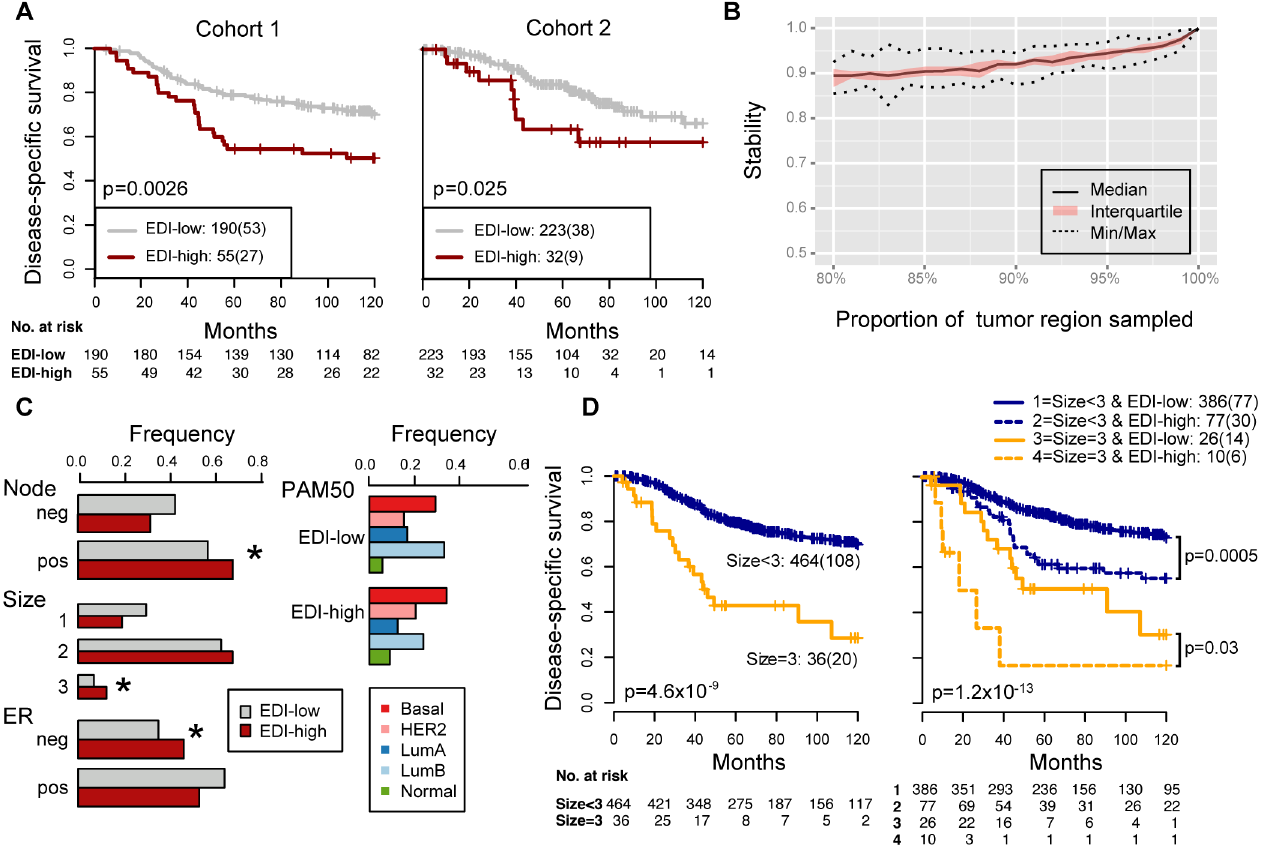
Fig 3. Reproducibility, stability, and independence of the EDI-high group in 507 grade 3 breast tumors. (A) Kaplan – Meier curves of disease-specific survival to illustrate the prognosis of EDI-high samples compared to other grade 3 samples in two independent patient cohorts. Shown below the graph are the number of patients (the number of disease-specific events) per group for EDI-low (grey) and EDI-high (red). (B) Agreement of the EDI subtyping between 100% data and resampling with progressively fewer tumor regions in 200 repeats. (C) Distribution of known subtypes in grade 3 tumors stratified by EDI; asterisks mark subtypes enriched in the EDI-high group. (D) Kaplan – Meier curves illustrating the duration of disease-specific survival according to tumor size (left) and improvement of stratification with the addition of EDI information